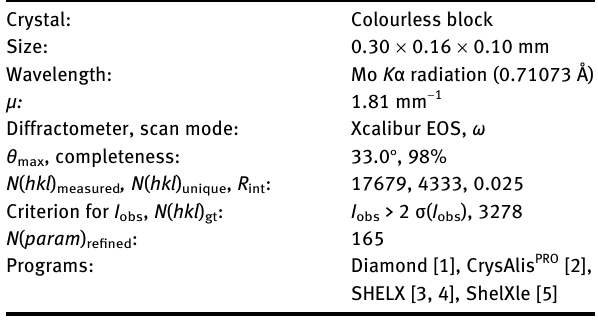
Table  : Data collection and